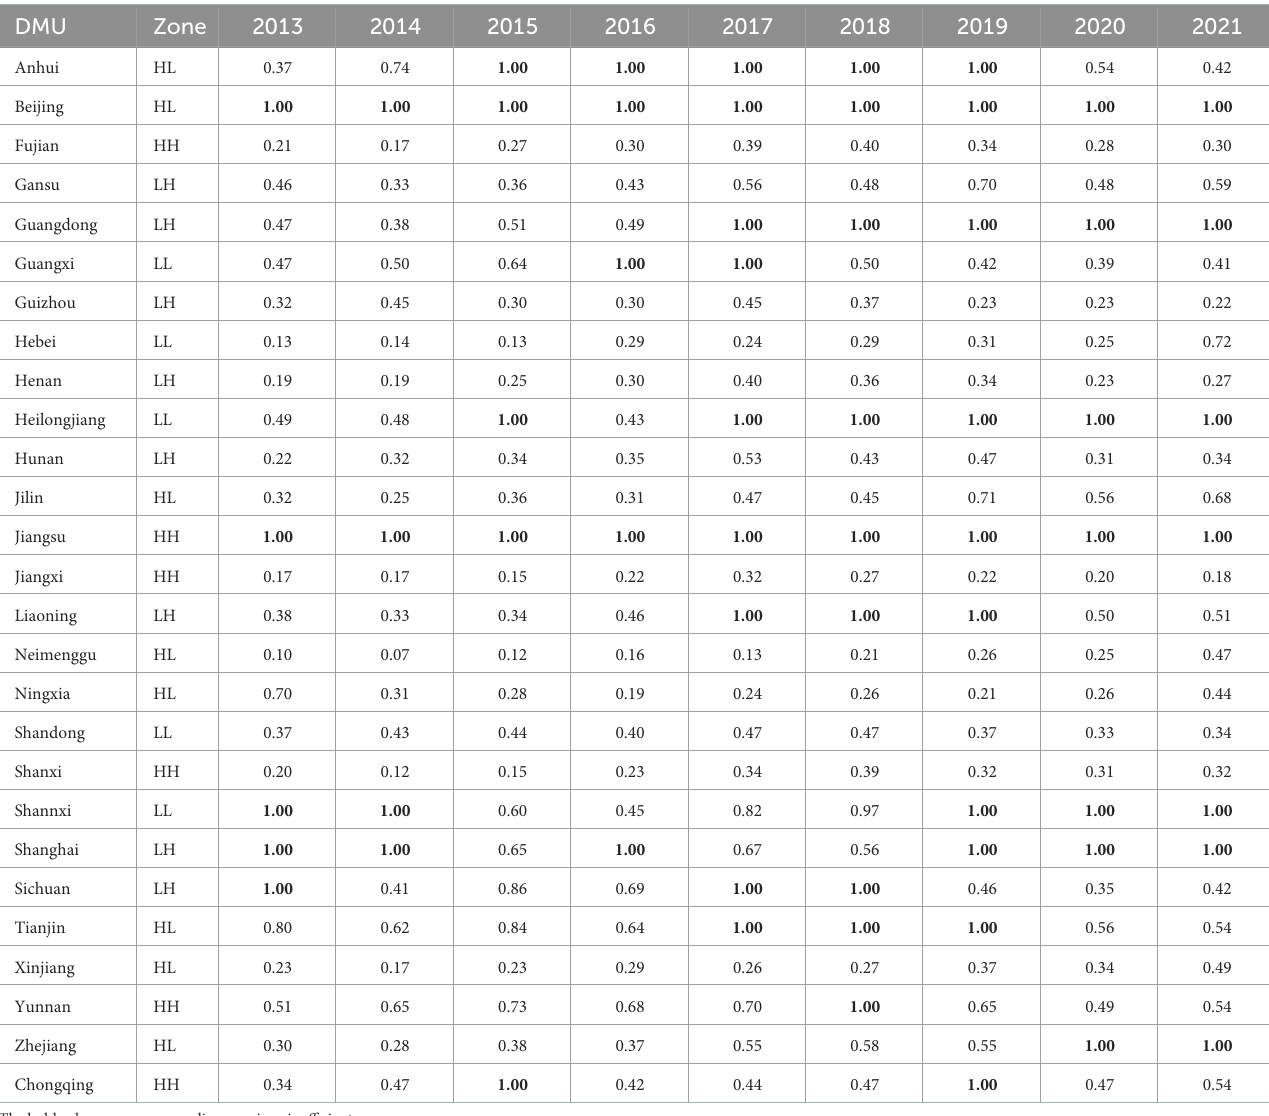
TABLE 3 Provinces’ ESI efficiency and means during 2013–2021.